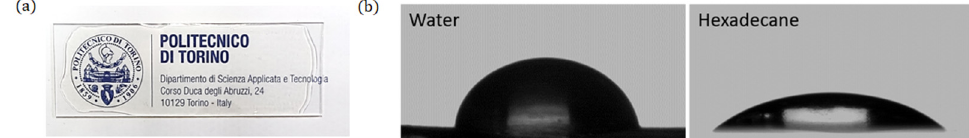
Figure 3. ( a ) The fully transparent MSC coating on a glass substrate; ( b ) images of water and hexadecane drops on the surface of MSC.